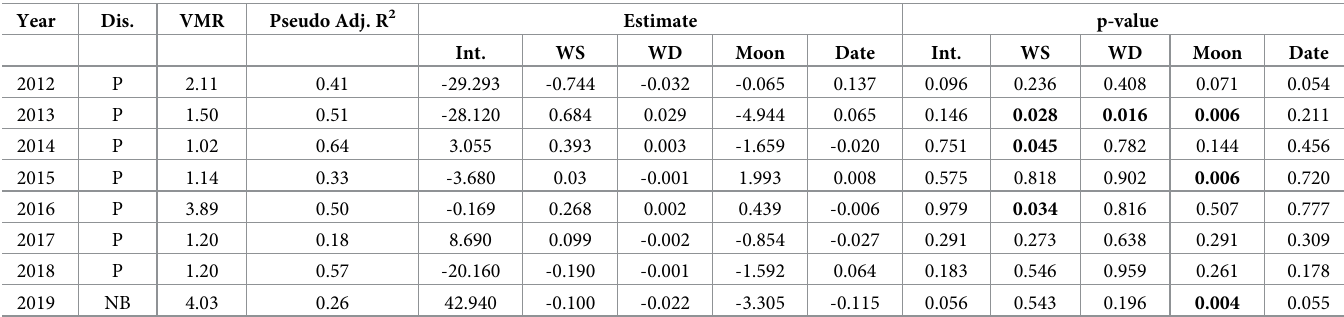
Fig 4. Fallout as a function of moon illumination and wind speed. Scatterplot of the number of grounded WTSH observed per survey, in relation to wind speed, and moon illumination. Open circles indicate the presence of fallout, with the increasing radius ranging from 1 to 10. Small solid dots indicate the absence of fallout (0 birds). https://doi.org/10.1371/journal.pone.0265832.g004 from the reference year (2012). The interaction between wind speed and moon had a positive coefficient (+0.23) suggesting that fallout was higher during periods of lower lunar illumina- tion and higher wind speed (Fig 4). Yearly models of WTSH fallout. In addition to the interannual variability in the number of WTSH observed during road surveys (Fig 3), the temporal aggregation of fallout across sur- veys was also highly variable, as evidenced by the varying dispersion (variance to mean ratio, VMR) observed yearly (1.02–4.03) (Table 2)). Moreover, due to the large proportion (46%) of absences (0 WTSH detected during a road survey), fallout counts followed a Poisson distribu- tion (1 < VMR < 2) in every year, except for 2019 (VMR = 4.03), when the negative binomial model yielded a lower AICc value. Table 2. Yearly model